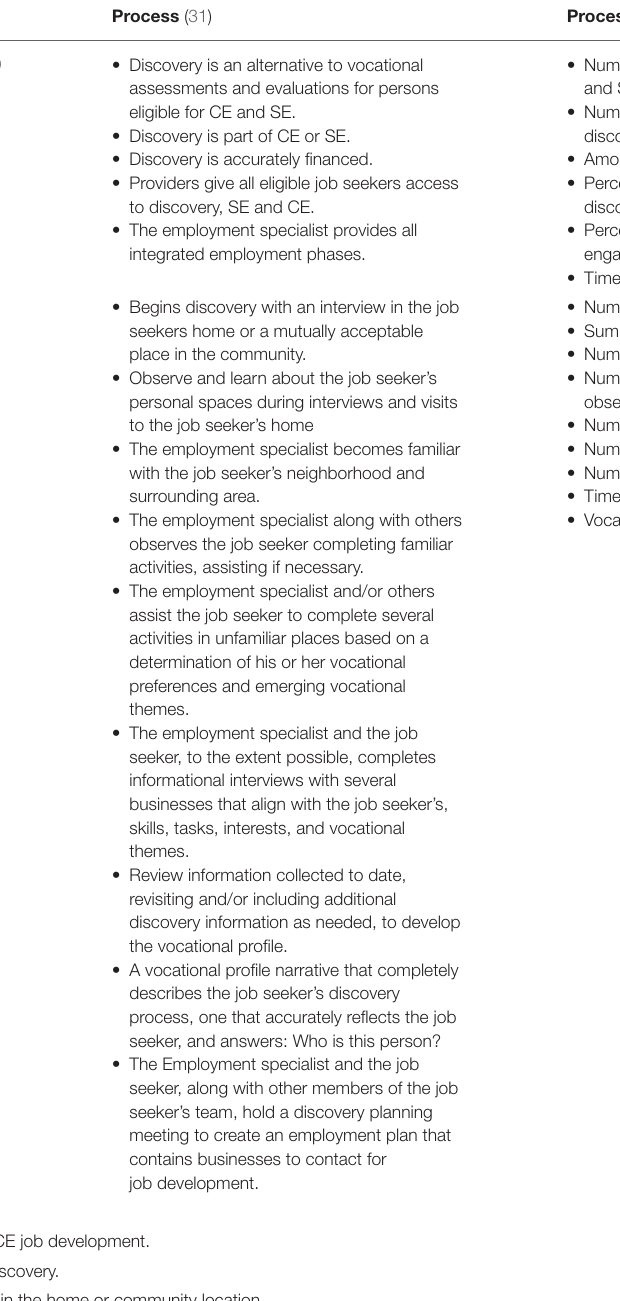
TABLE 1 | Process, process measures, and proximal and distal outcomes for CE